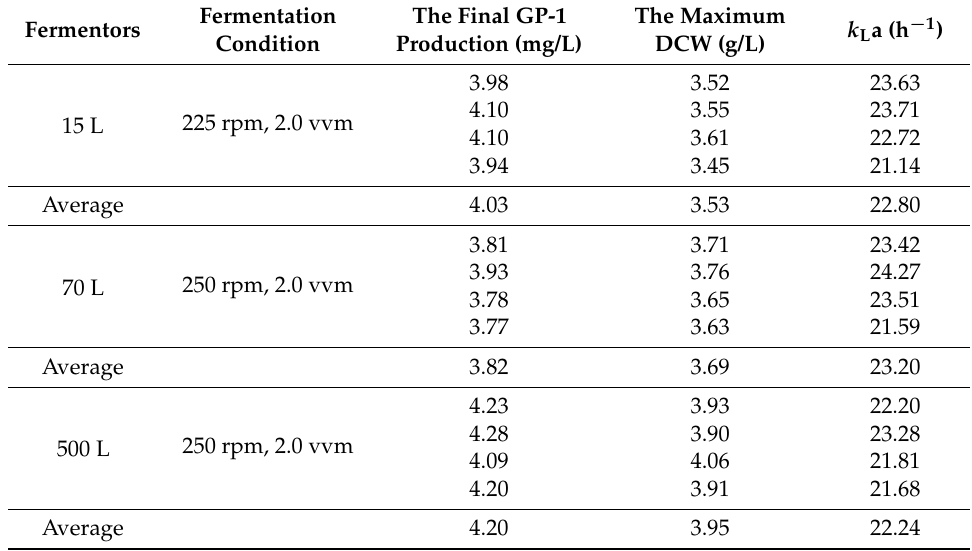
Table 4. The final GP-1 production, the maximum DCW and k L a in pilot-scale fermentors. Fermentors